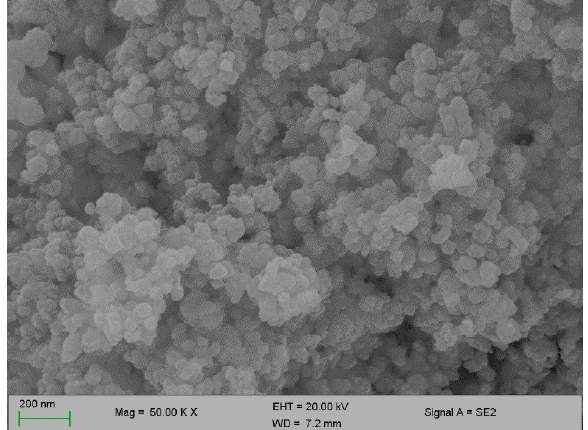
Figure 2. SEM surface morphology of the bioflocculant.